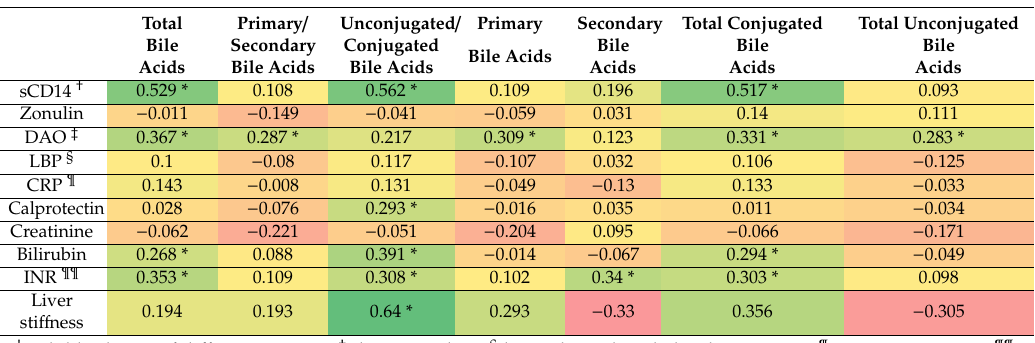
Figure 8. Principal coordinates analysis (PCoA) plot for serum bile acid composition using non-metric multidimensional scaling (Bray–Curtis) for analysis. Orange: SC-CIP, violet: CIP controls, turquoise: cirrhosis, yellow: healthy. Each point on the diagram presents one study proband. Significantly di ff erent bile acid profiles were found in healthy compared to SC-CIP, CIP control and cirrhosis groups and between SC-CIP and cirrhosis groups. R = 0.26, p < 0.001; SC-CIP–healthy: p < 0.001; cirrhosis–healthy: p < 0.001; CIP controls–healthy: p = 0.006. NMDS = Non-metric multidimensional scaling. Table 12. Heatmap showing correlations between bile acid profiles and markers of gut permeability, bacterial translocation, intestinal and systemic inflammation and liver function parameters. Spearman’s correlation coe ffi cient is shown. Significant results ( p < 0.05) are indicated by *. The greener a field gets, the better the positive correlation, the more red a field gets, the more pronounced the negative correlation